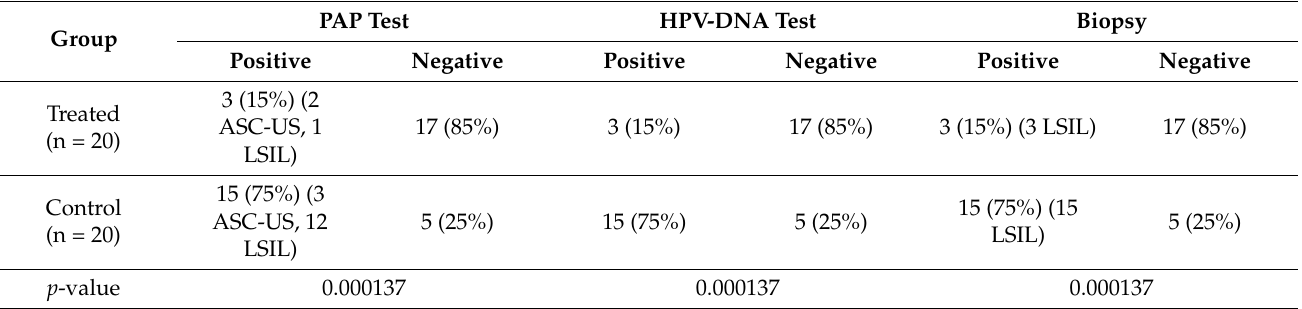
Table 2. Changes in HPV-DNA content of cervical pre-cancerous lesions by treatment with a tablet per day containing 200 mg of EGCG, 400 mcg of FA, 1 mg of vitamin B12, and 50 mg of hyaluronic acid for 12 weeks. Post-Treatment Effects on DNA Content (no. Patients) Group Increase in Decrease in No Change Disappear DNA Content DNA Content Treated 17 (85%) (n = 20) Control (n = 20) Table 3. Overall response rates after 12 weeks of the treatment versus natural histology of HPV- induced lesions as control. PAP Test: Papanicolau Test; HPV: Human Papilloma Virus; ASC-US: Atypical Squamous Cells of Undetermined Significance; LSIL: Low-grade Squamous Intraepithe- lial Lesion. PAP